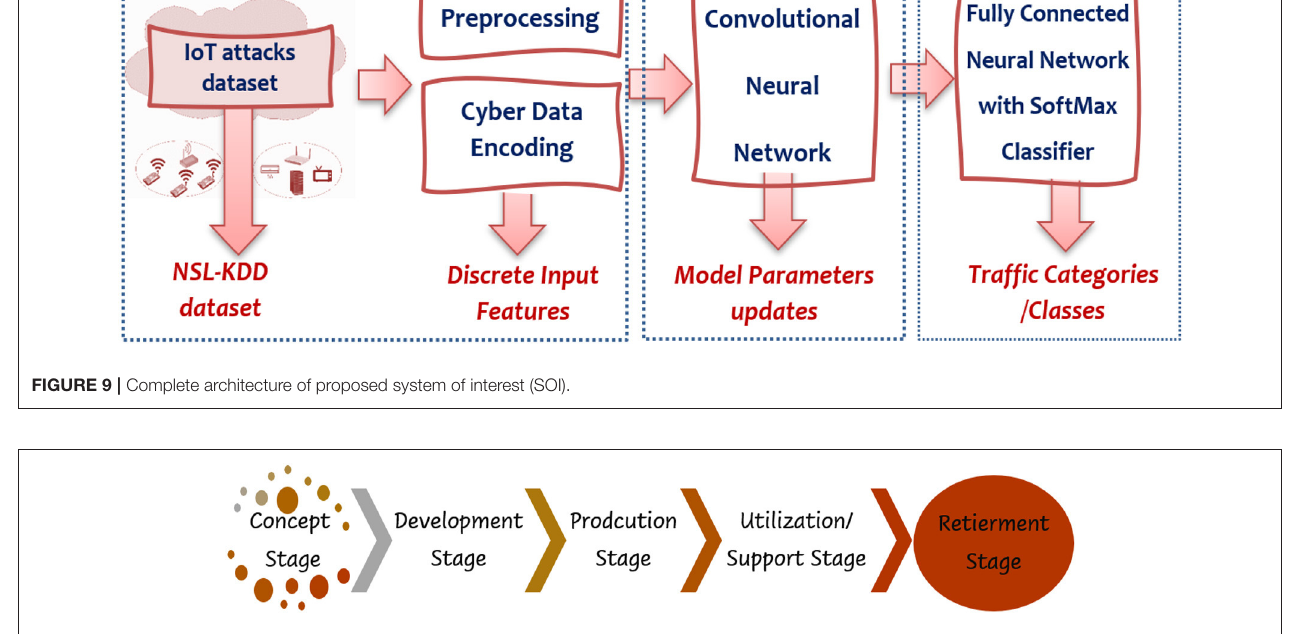
FIGURE 10 | Conventional system engineering life cycle phases using